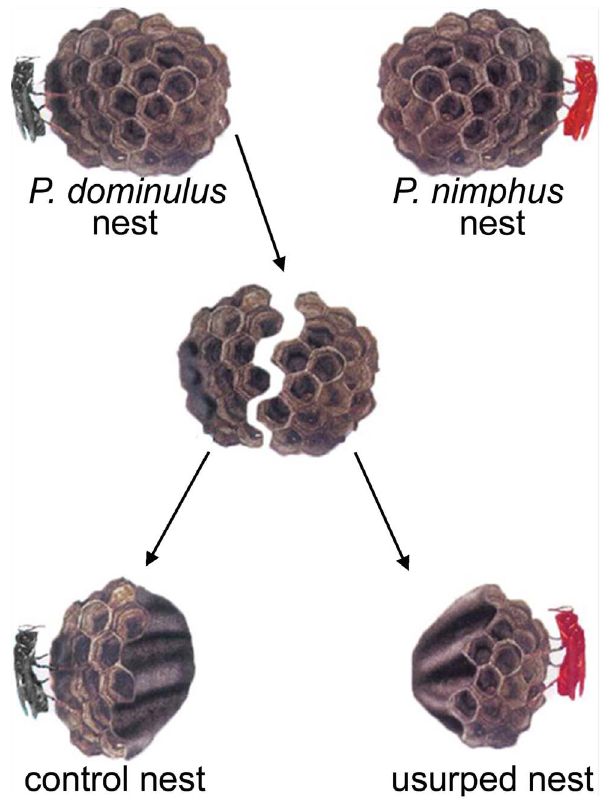
Figure 1. Nest cutting. The experimental procedure of cutting P. dominulus nests into two parts and assigning a half to the original foundress (in black) and the other to a P. nimphus foundress (in red) to obtain a control nest and a usurped